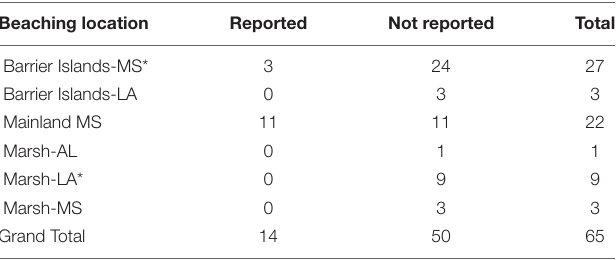
TABLE 5 | Location and public reporting of drift study carcasses that beached in Mississipi (MS), Alabama (AL), and Louisiana (LA) during 2017. Several carcasses were reported more than